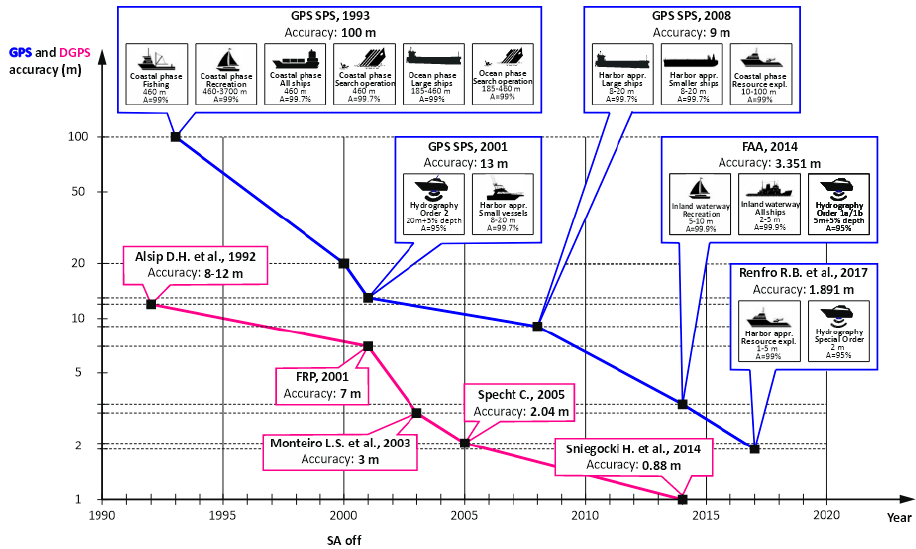
Figure 1. Changes in the GPS and DGPS systems’ accuracies over the recent years, based on se-lected documents and authors. Own study based on [2–6,17,18,20–22]. Table 1. The requirements for positioning accuracy during the hydrographic survey performance under a specific order